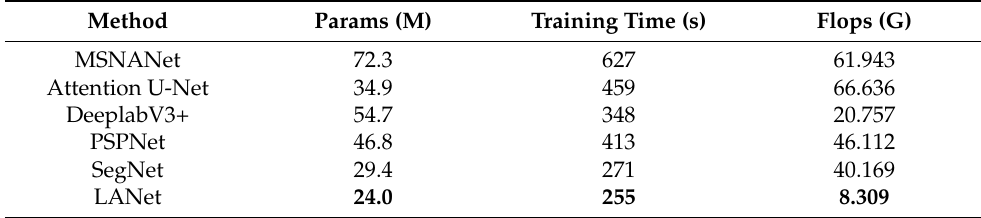
Table 3. Comparison in terms of computational time. Bold numbers indicate the best results. The size of the input was 256 × 256.